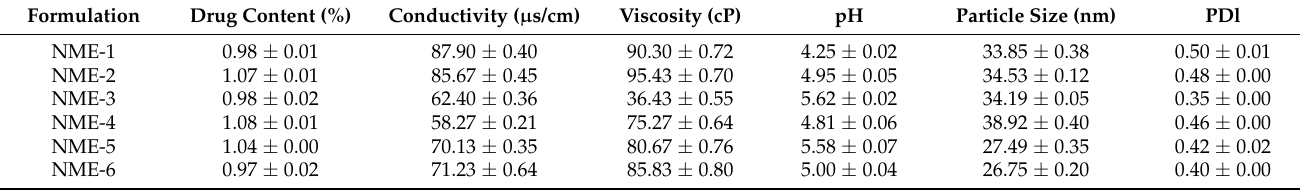
Table 3. Characterization of selected naringin-loaded microemsulsions. Data represent the mean ± SD (n = 3).